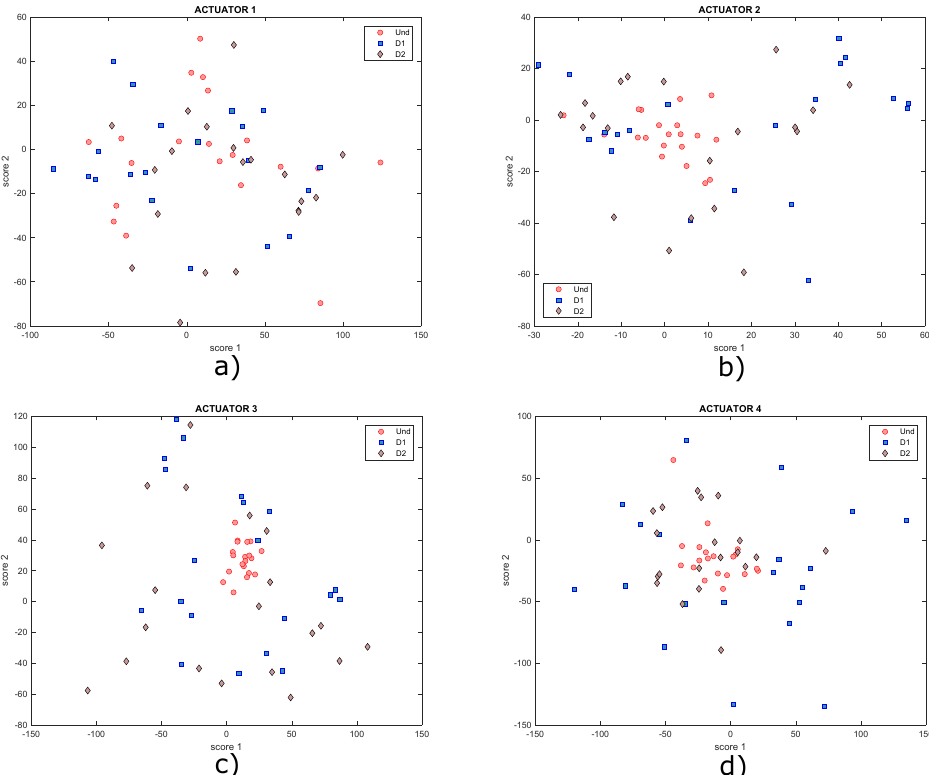
Figure 17. Graphs of score 1 vs. score 2 for actuation phases: ( a ) 1; ( b ) 2; ( c ) 3 and ( d ) 4.